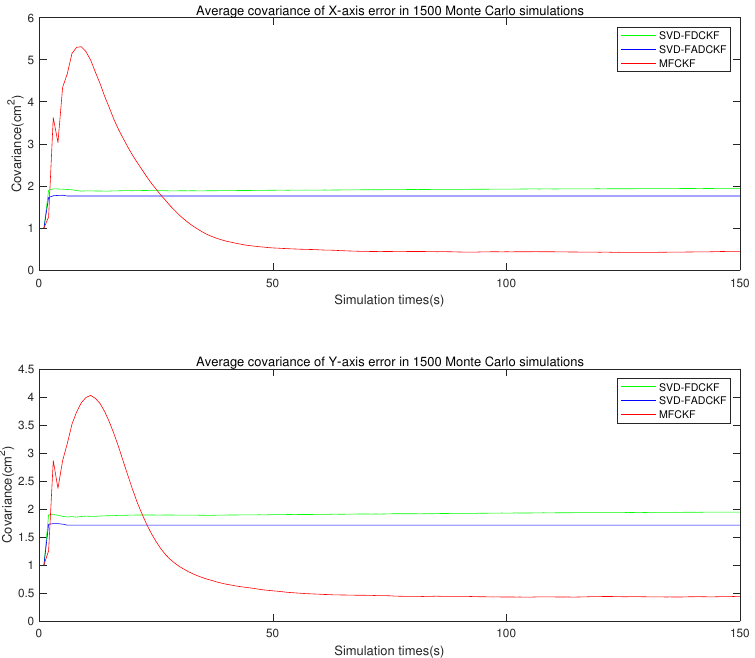
Figure 10. Average estimated error covariance in 1500 Monte Carlo experiments (3 algorithms). Figure 11 shows the process of covariance converges in iteration. This is a randomly selected set from the 1500 Monte Carlo experiments. We can get a conclusion similar to Figure 10, the proposed algorithm has better performance in estimation error covariance after convergence but poor initial overshoot and dynamic response performance. In addition, in the 1500 times Monte Carlo experiments, an average of 101.95 s per 150 s, the positioning error is contained in the error covariance curve, accounting for 67.97% of the total simulation time.